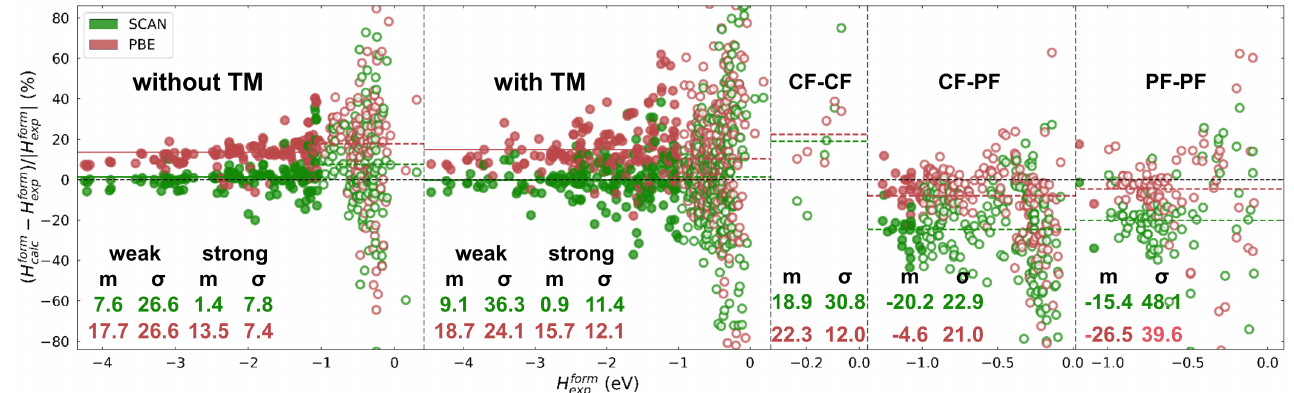
Figure 5. Deviations of the formation enthalpy calculated within SCAN and PBE as a function of the experimental results for binary intermetallics with and without TM ions. The first panel contains 266 compounds without TM ions [19,46], the second panel contains 513 compounds with one TM ion [19,46], and the last panels include 322 TM compounds [43,46,50,56]. The experimental values referenced in [19,43,46,50,56] are shown as the zero dash line. Filled and open symbols indicate strongly ( | H form exp | > 1) and weakly ( | H form exp | < 1) bonded compounds, correspondingly. CF-CF is the completely filled d -shell for both TMs in a compound; CF-PF is the completely filled and partially filled d -shells for TMs in a compound; and PF-PF is the partially filled d -shell for both TMs in a compound. The values of m and σ denote the mean and standard deviation from H form exp for each group of